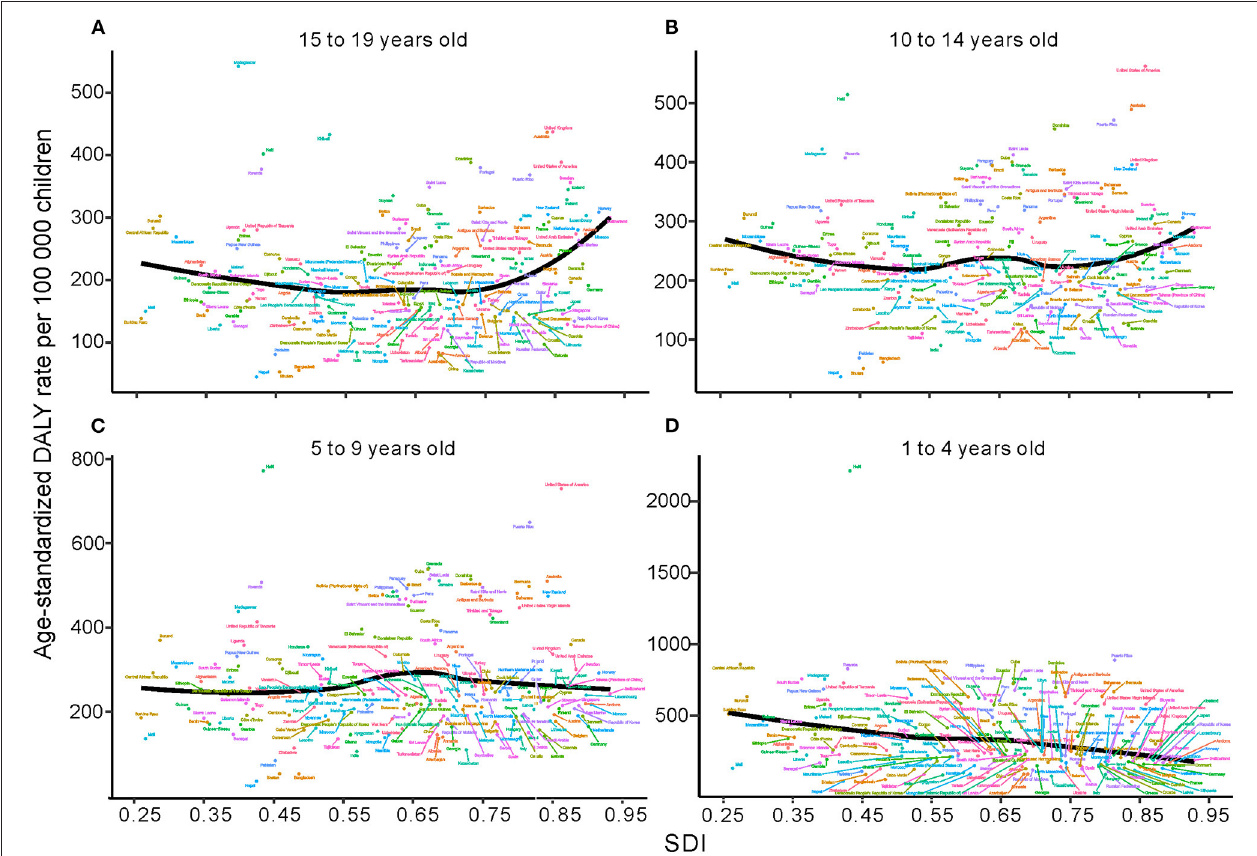
FIGURE 5 | Age-standardized DALYs due to childhood asthma by country and SDI, 2019; the black line represents expected values. (A) Change trends of age-standardized DALYs by country and SDI in 15 to 19 year olds. (B) Change trends of age-standardized DALYs by country and SDI in 10 to 14 year olds. (C) Change trends of age-standardized DALYs by country and SDI in 5 to 9 year olds. (D) Change trends of age-standardized DALYs by country and SDI in 1 to 4 year olds. DALYs = disability adjusted life years, SDI, sociodemographic